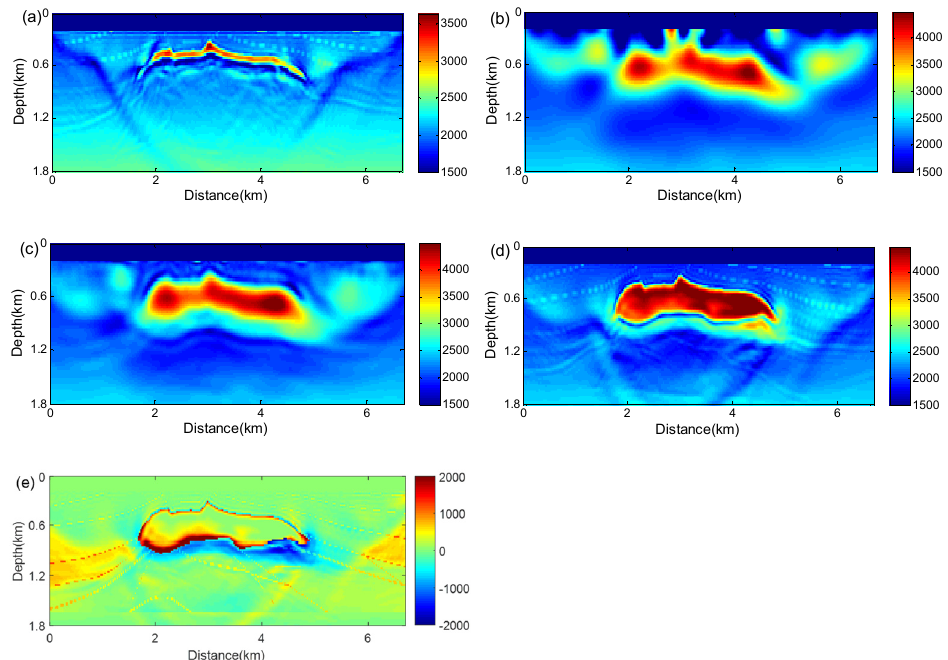
Figure 6. Inversion results by conventional DEI and FWI. ( a ) Conventional FWI result. ( b ) Conven- tional DEI result. ( c ) Conventional DEI + FWI result with data frequency band of 4–8Hz. ( d ) Con- ventional DEI + FWI (4–8Hz) + FWI(4–18Hz) result. ( e ) Difference profile between Figures 4a and 6d.